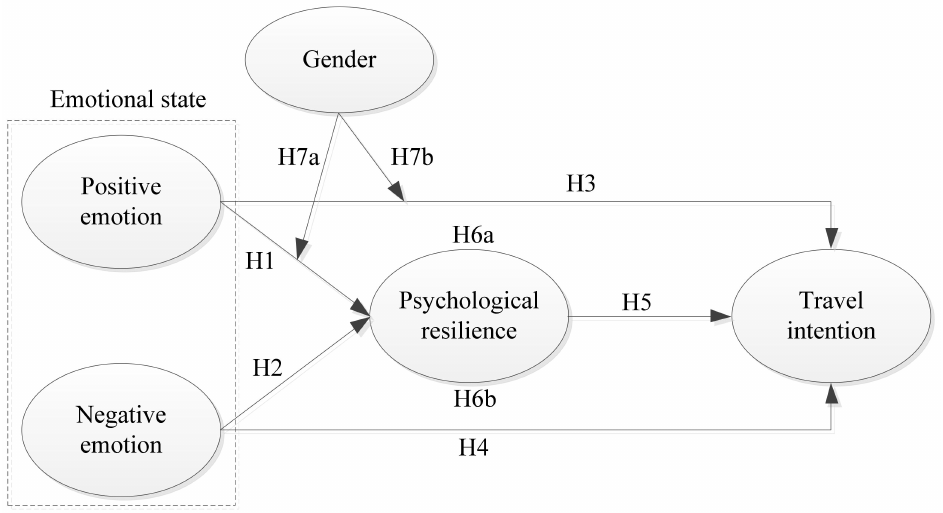
Figure 1. The conceptual framework of this study.